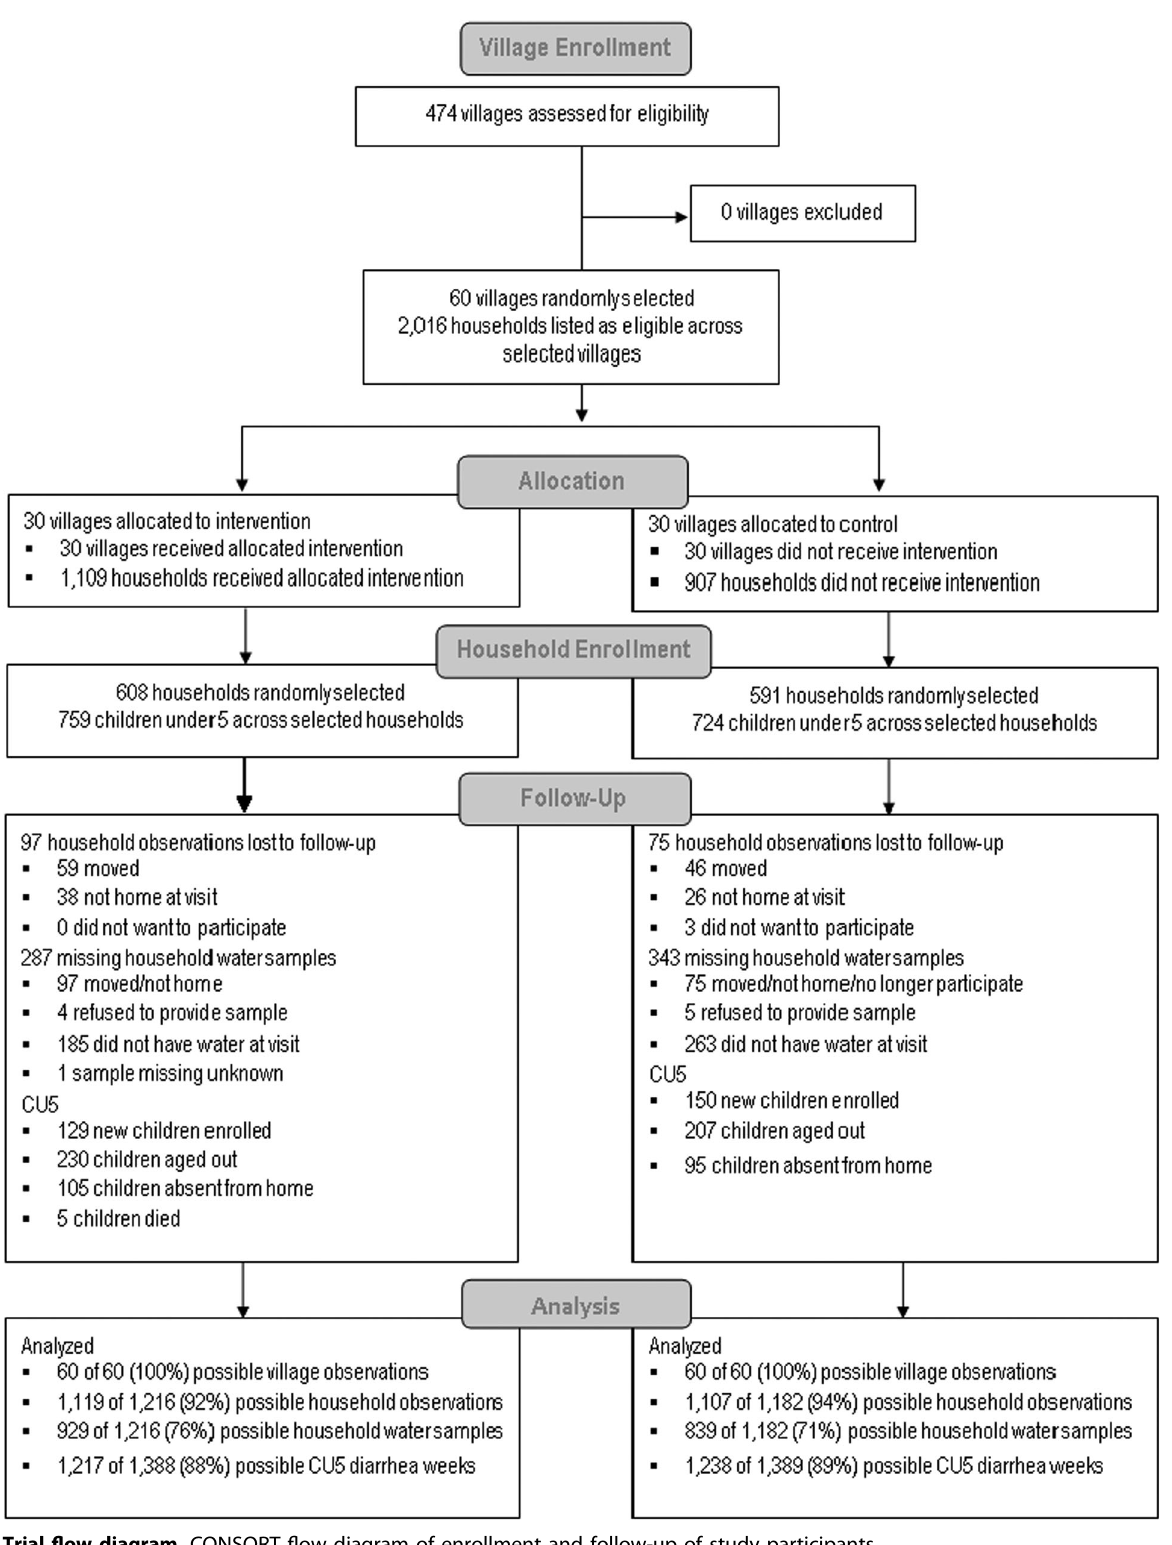
Fig. 1 Trial fl ow diagram. CONSORT fl ow diagram of enrollment and follow-up of study estimating equations with robust standard errors to account for clustering within villages. The intervention reduced the proportion of drinking water with detectable E. coli by 20% (PR 0.80, 95% CI, 0.74 – 0.87, p value < 0.001) compared to the control. It reduced the proportion of drinking water samples with moderate and higher